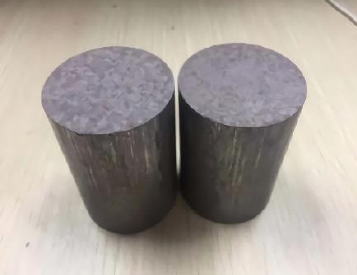
Figure 18. Press-formed PBX sample.